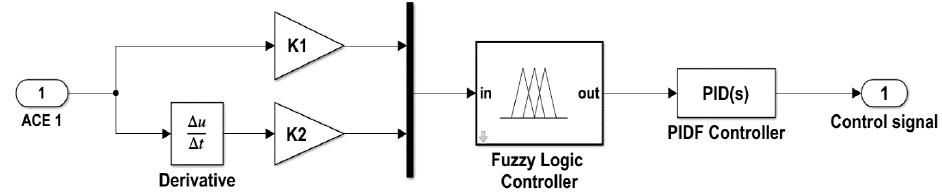
Figure 4. The MPA-based fuzzy PIDF Controller’s structure. Table 2. The rule set of the fuzzy logic